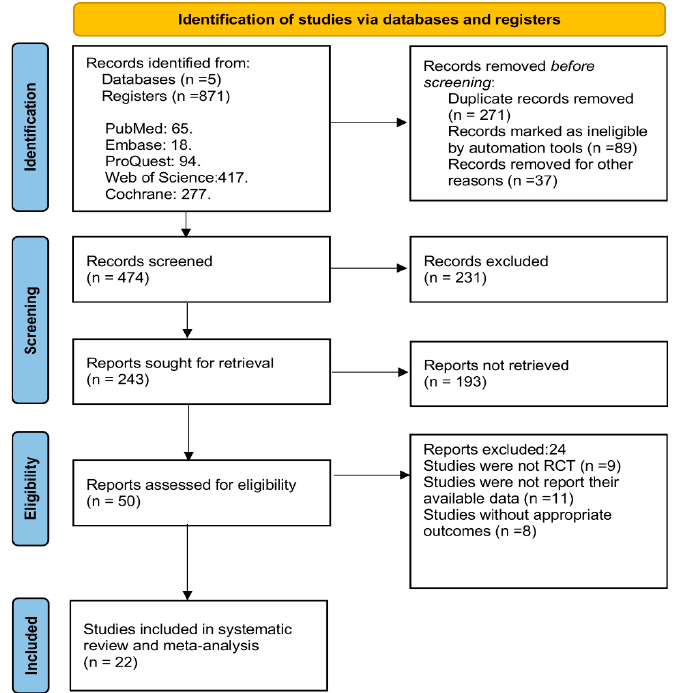
Figure 1. PRISMA flow chart of study selection.